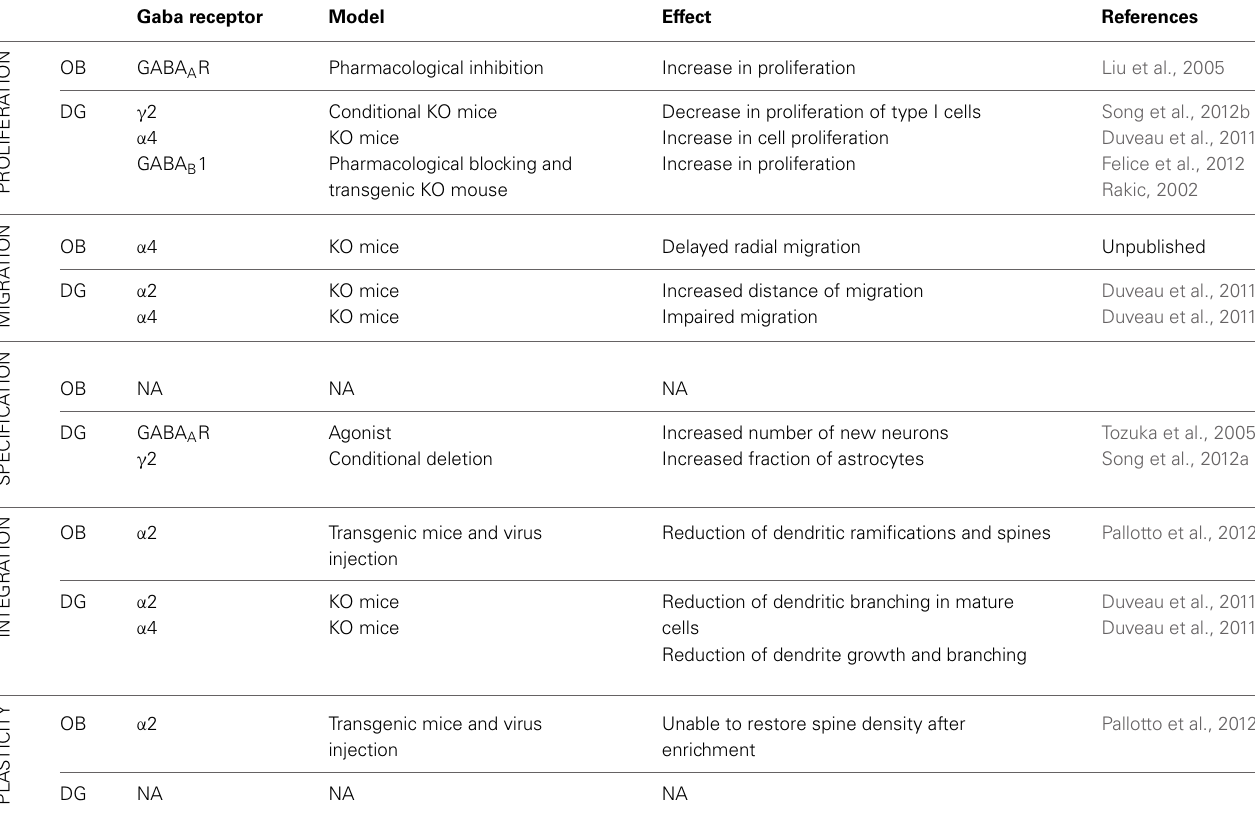
Table 2 | Comparison of the role of different GABA receptor and receptor subunits in different stages of mouse adult neurogenesis in the OB and